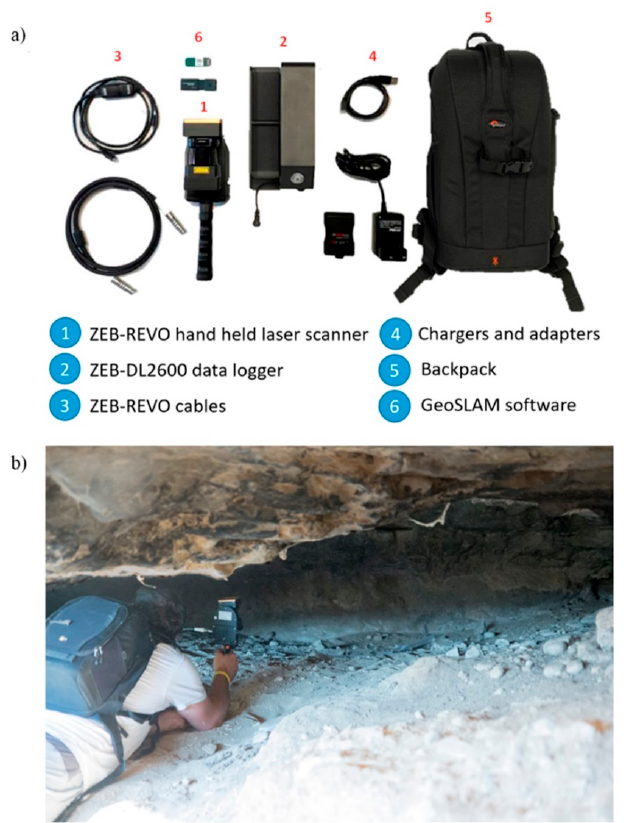
Figure 4. Wearable Mobile LiDAR System device used for the 3D digitalization of the cave: ( a ) main components of the WMLS device used and ( b ) photo acquired during the data acquisition. The high portability of the system is worth mentioning. Table 6. Technical specifications of the Wearable Mobile LiDAR System used.